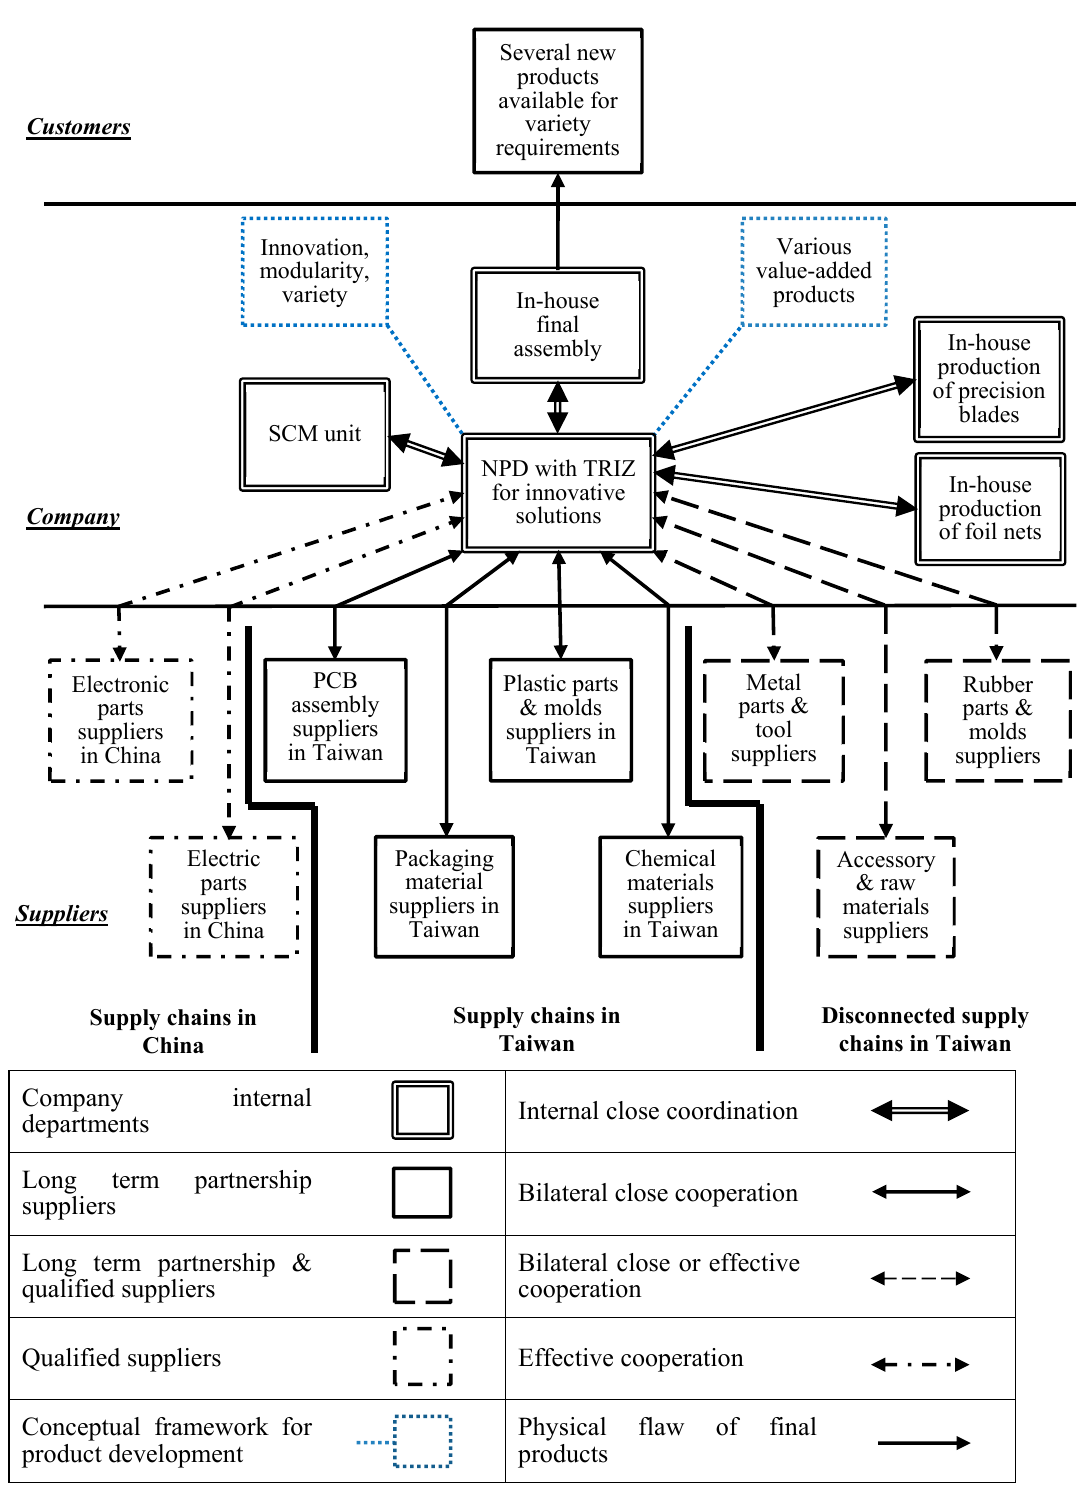
Figure 9. Case company’s current supply chains.